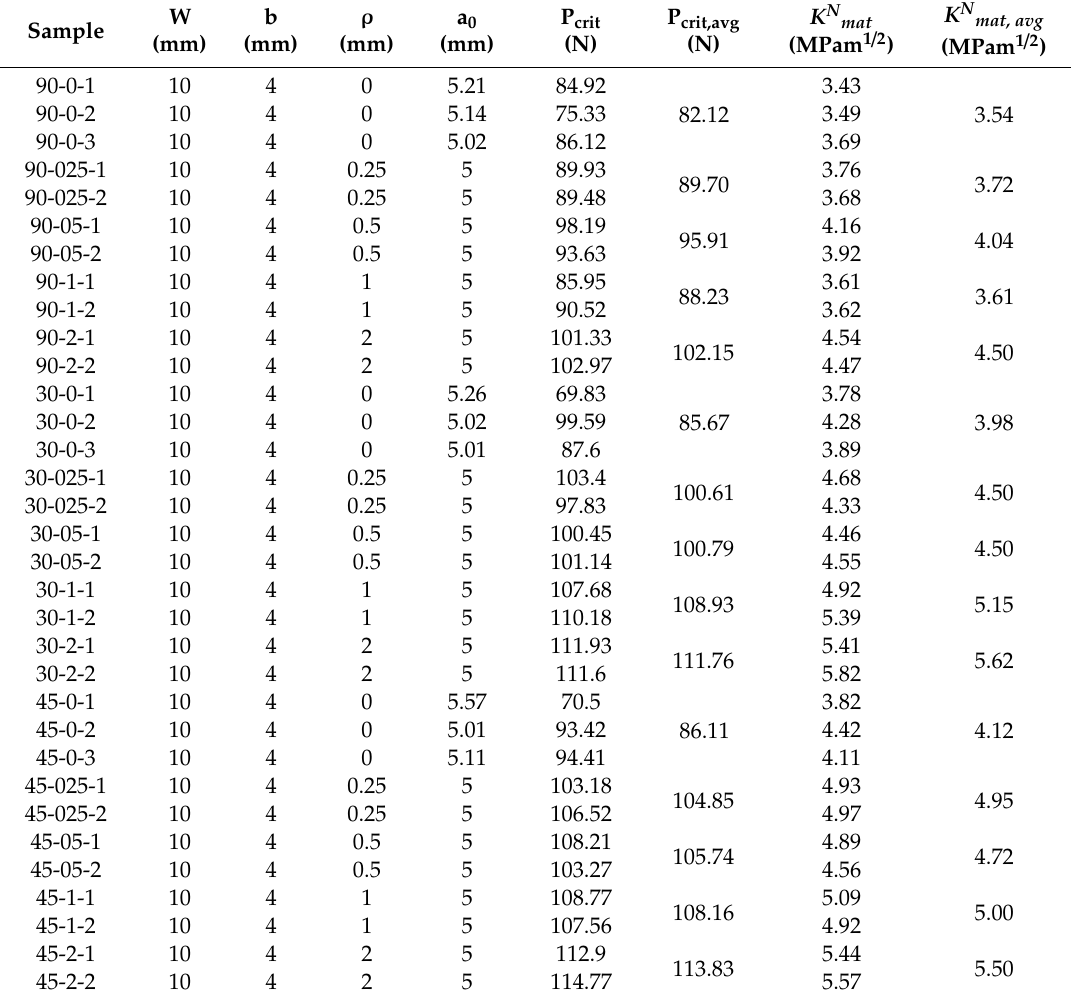
Table 2. Geometry of the di ff erent specimens and experimental results. W: width; b: thickness; ρ : notch radius; a 0 : initial crack length; P crit : maximum load; K N mat : apparent fracture toughness; avg subscript refers to average